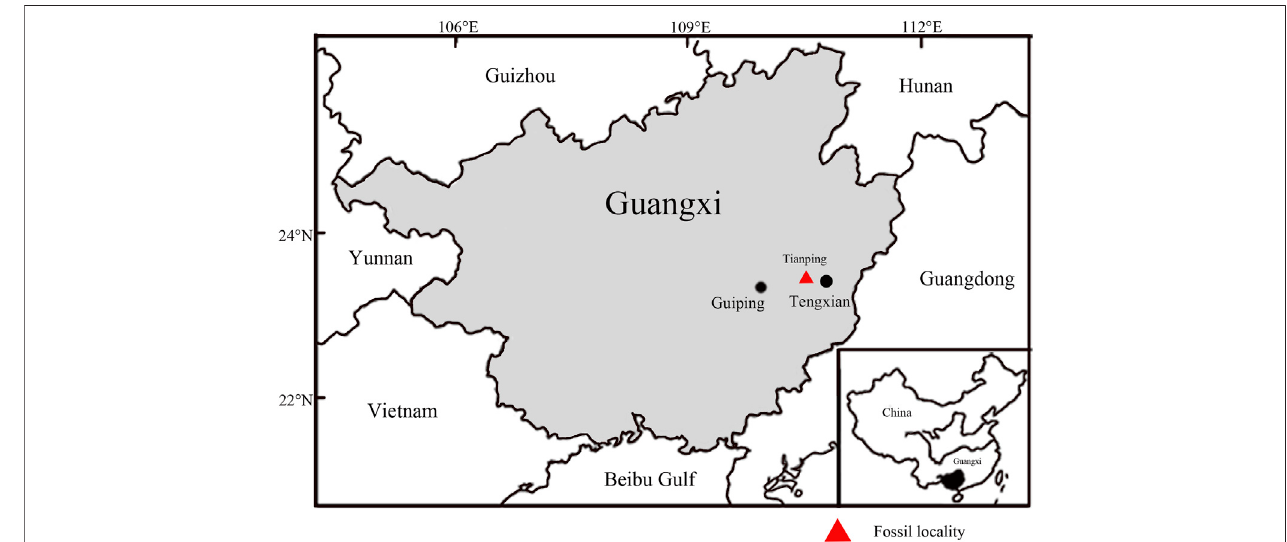
FIGURE 2 | Map showing the fossil locality (red triangle, modi fi ed from Han et al., 2018).